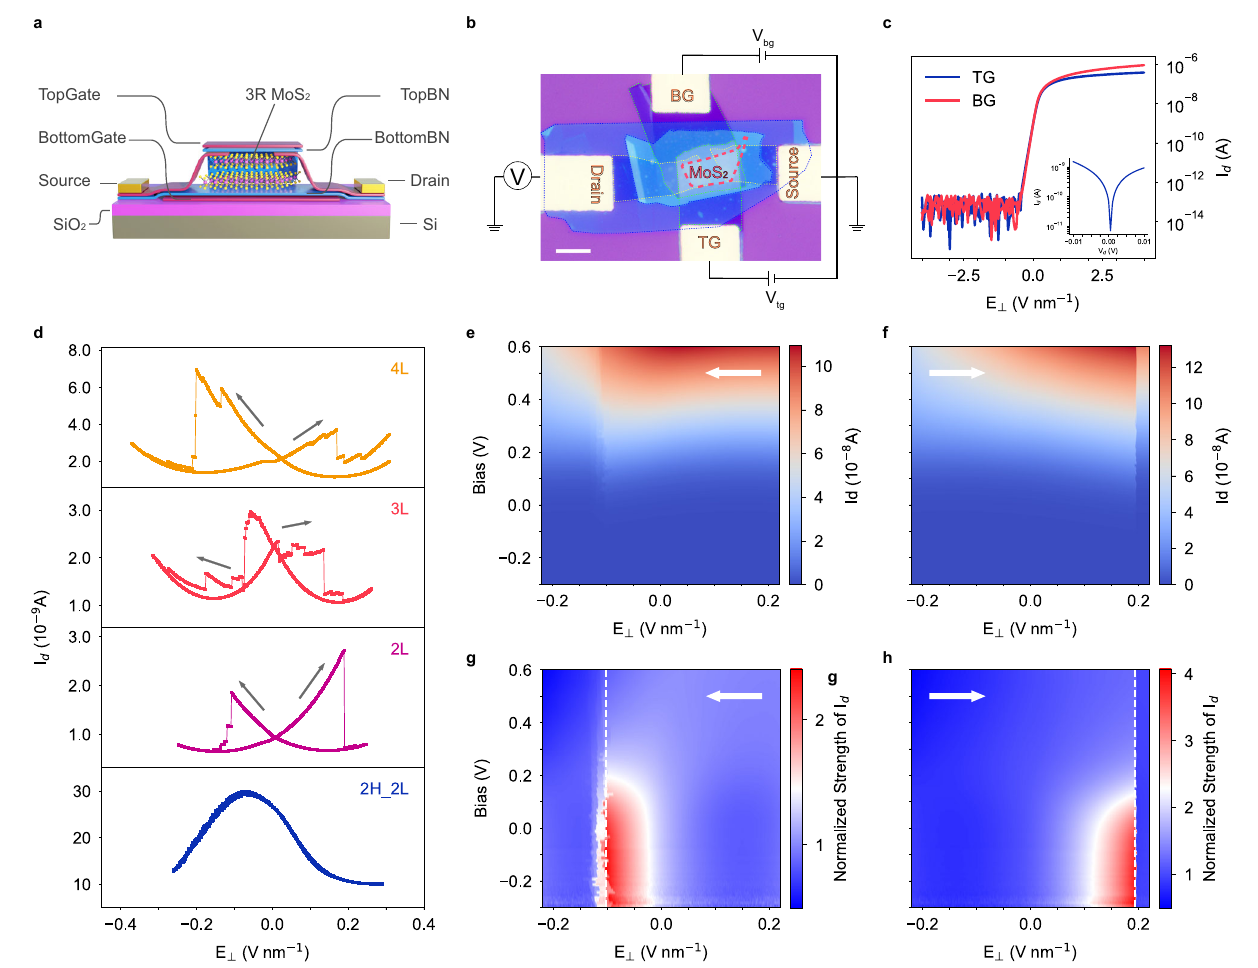
Fig.2| Dynamictransport propertiesofdual-gateFETdevices.a Schematicofa typical3RMoS 2 dual-gatedevice. b Micrographimageofabilayerdevice.Thescale baris10 μ m. c Draincurrent( I d )asafunctionoftopgateandbottomgatevoltages in bilayer 3R MoS 2 .The insetisthe plotof I d against V d inbilayer 3R MoS 2 without gating voltage. d Drain current ( I d ) as a function of vertical electric fi eld ( E ⊥ ) in bilayer 2H MoS 2 and 3R MoS 2 of different layer numbers in a loop of sweep mea- surement. Upward is de fi ned as the positive electric fi eld direction. Drain current